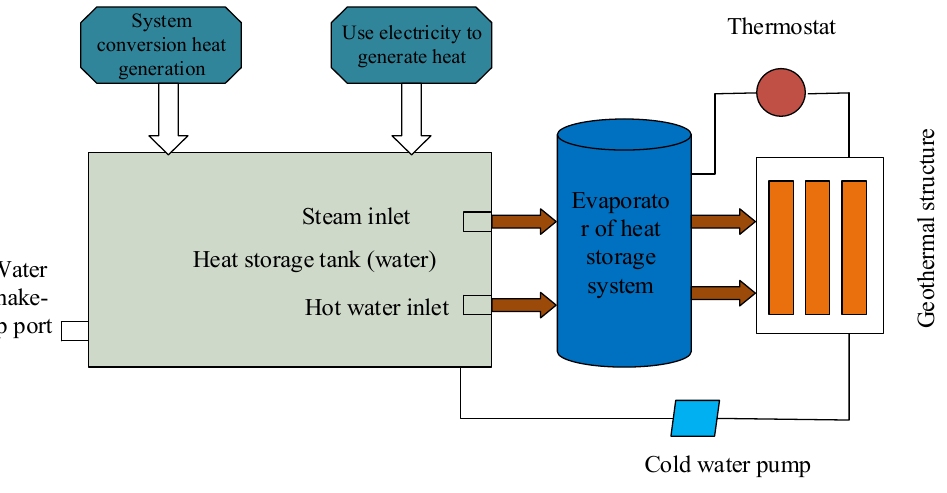
Figure 2. Structural diagram of a heat storage tank.